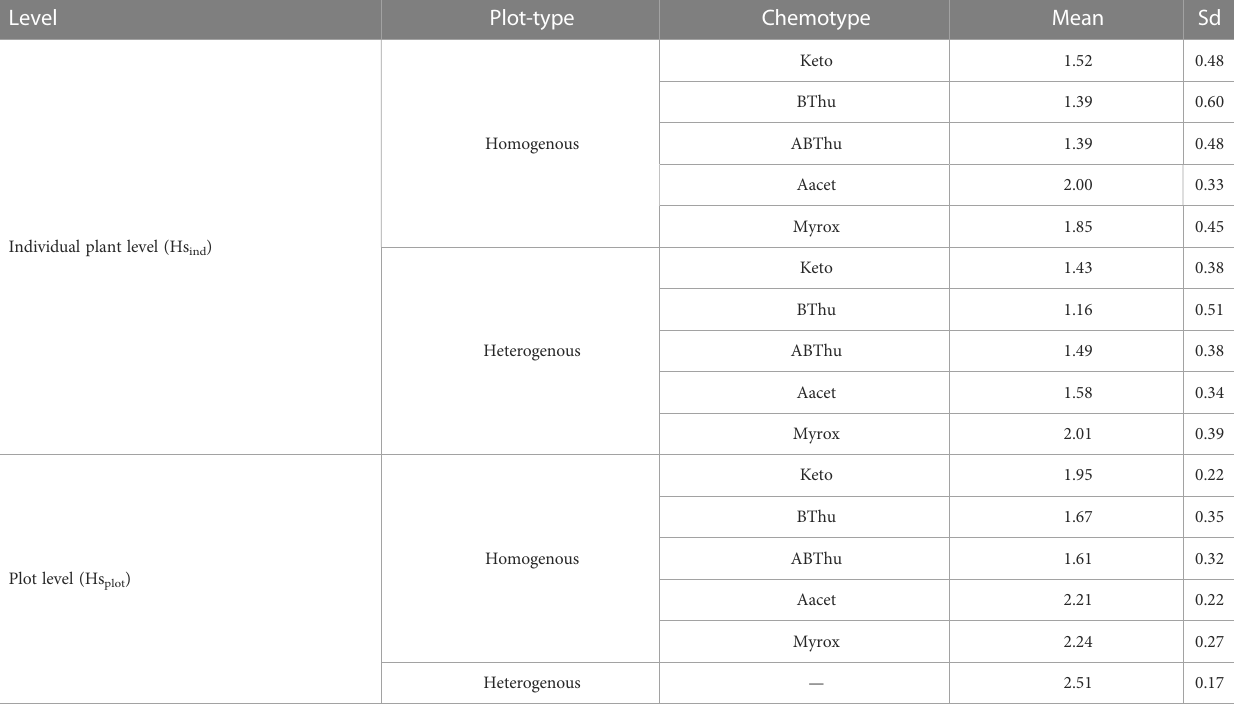
TABLE 2 Shannon-diversity (Hs) of the fi ve tested chemotypes calculated based on the relative terpenoid composition obtained from GC-MS measurements of youngest, fully developed leaf samples taken in calendar week 25 from each plant planted in the common garden.